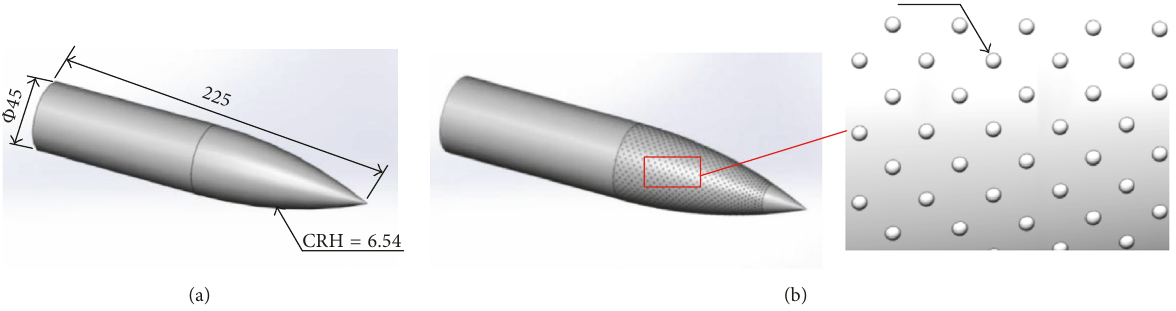
Figure 2: The projectile with convex nonsmooth nose surface.